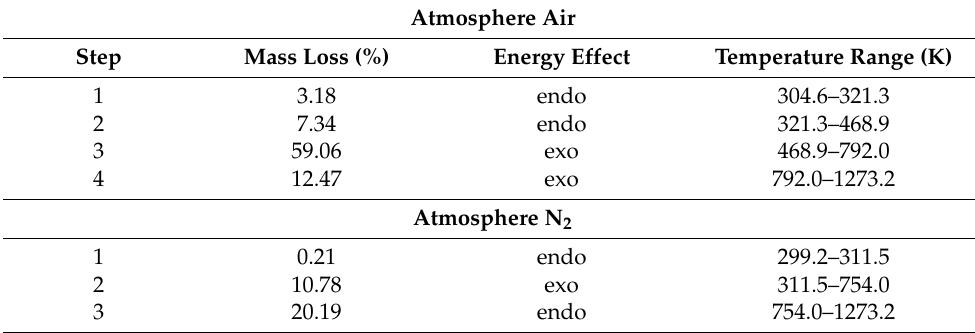
Table 3. TGA-DTA analysis results of biochar